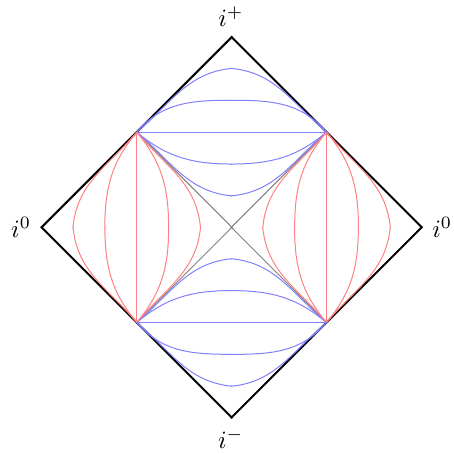
Figure 3 . A hyperbolic foliation of Minkowski